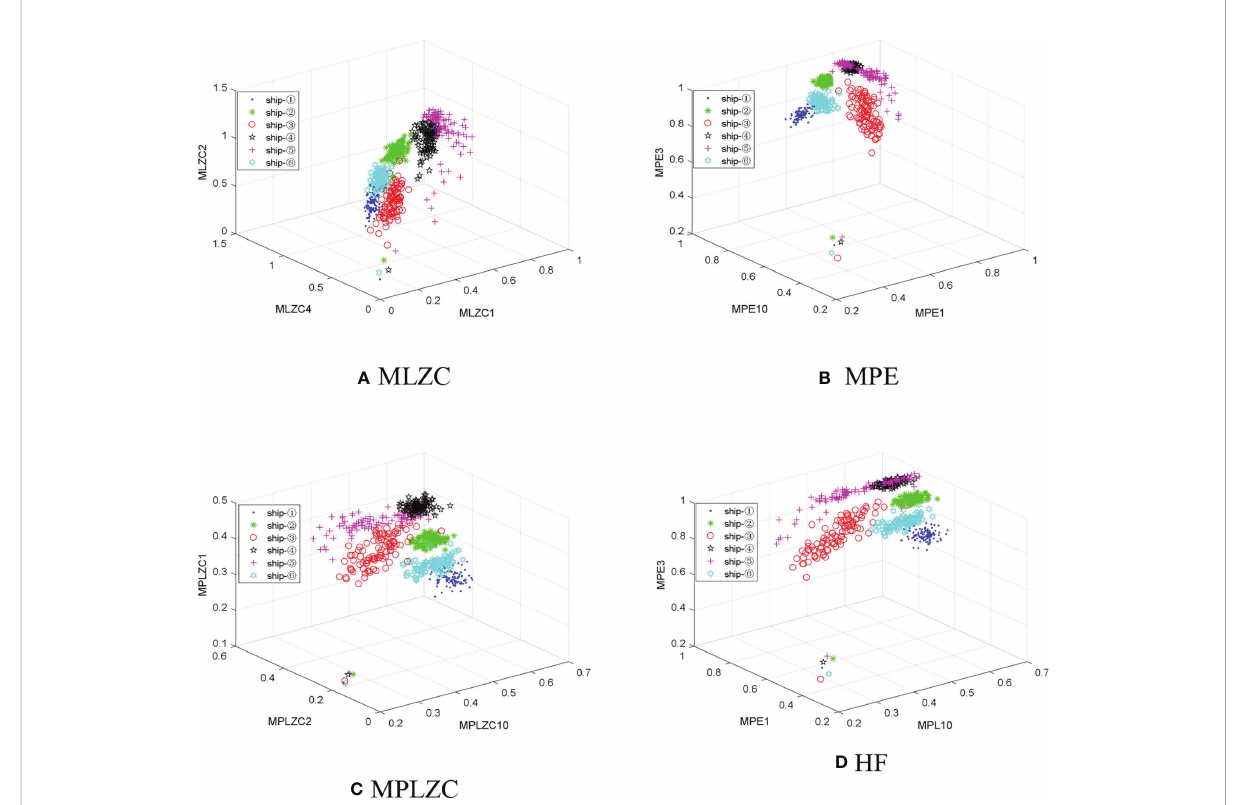
FIGURE 10 The triple feature distributions under the highest ARRs of six S-Ss: (A) MLZC, (B) MPE, (C) MPLZC, (D) HF.